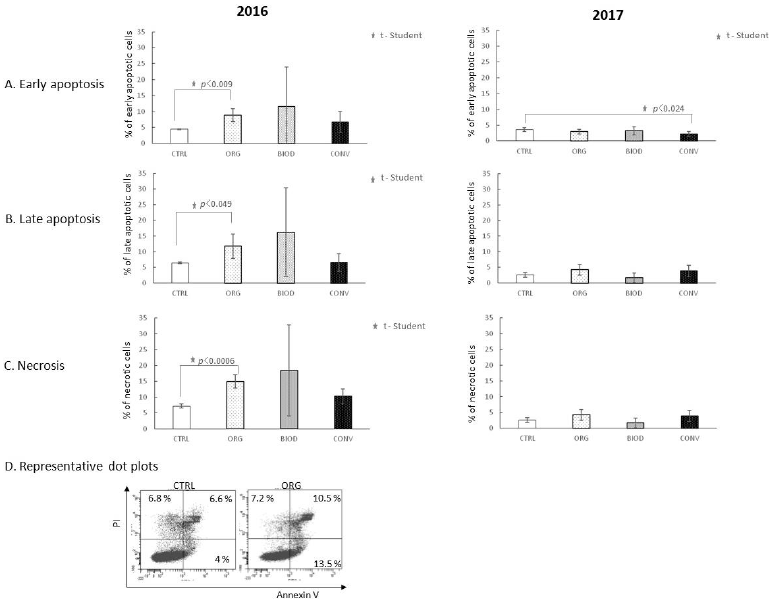
Figure 3. Apoptosis and necrosis-inducing activity of blueberry extracts. ( A ) Effect of blueberry extracts on the early phase of apoptosis; ( B ) effect of blueberry extracts on the late phase of apoptosis; ( C ) effect of blueberry extracts on the induction of necrosis; ( D ) representative dot plots for AnnexinV/FITC and PI staining of the sample showing statistically significant differences. CTRL—HT-29 cell culture without blueberry extracts; ORG, BIOD, CONV—HT-29 cell culture with blueberry extracts from particular types of production system (ORG: organic, BIOD: biodynamic, CONV: conventional).